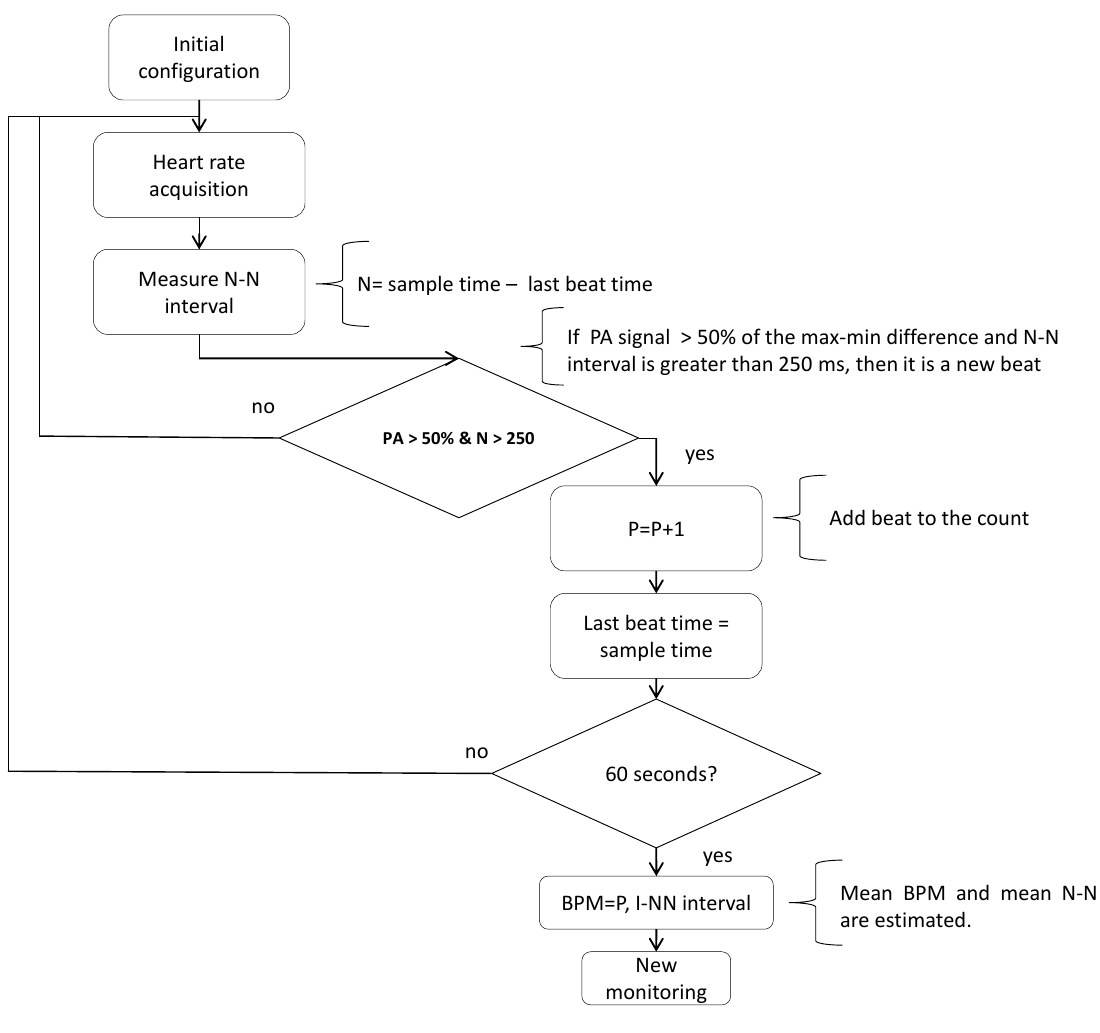
Figure 6. Flow diagram for the HR